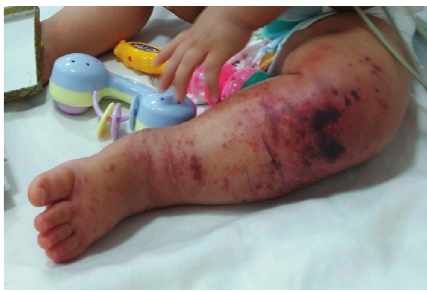
Figure 1: Peripheral gangrene as a presentation of Kawasaki